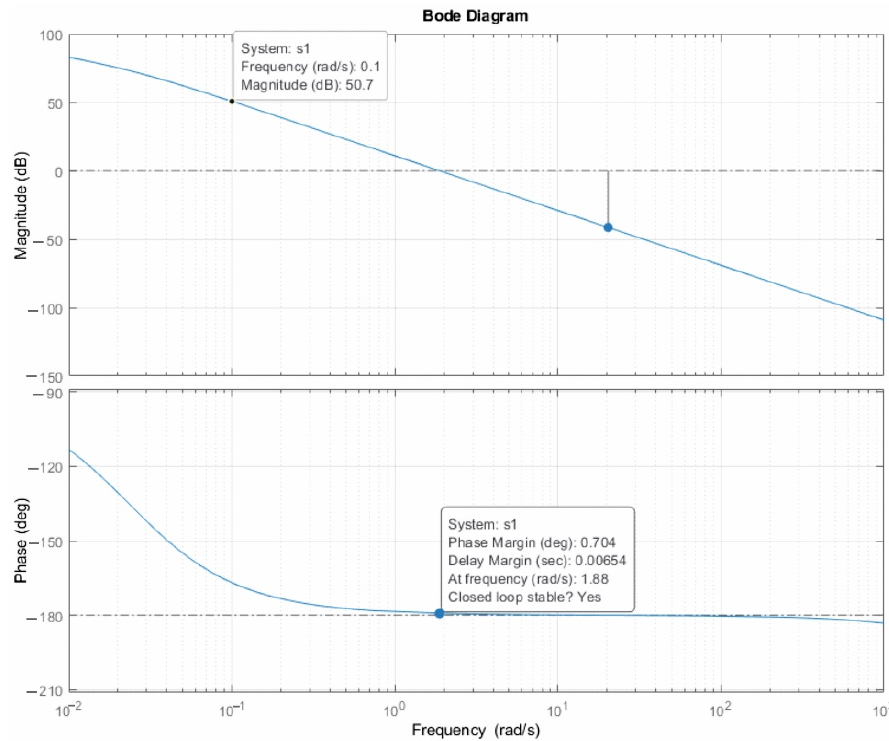
Figure 20. Bode characteristic of the system S ( s ) with a partial controller.